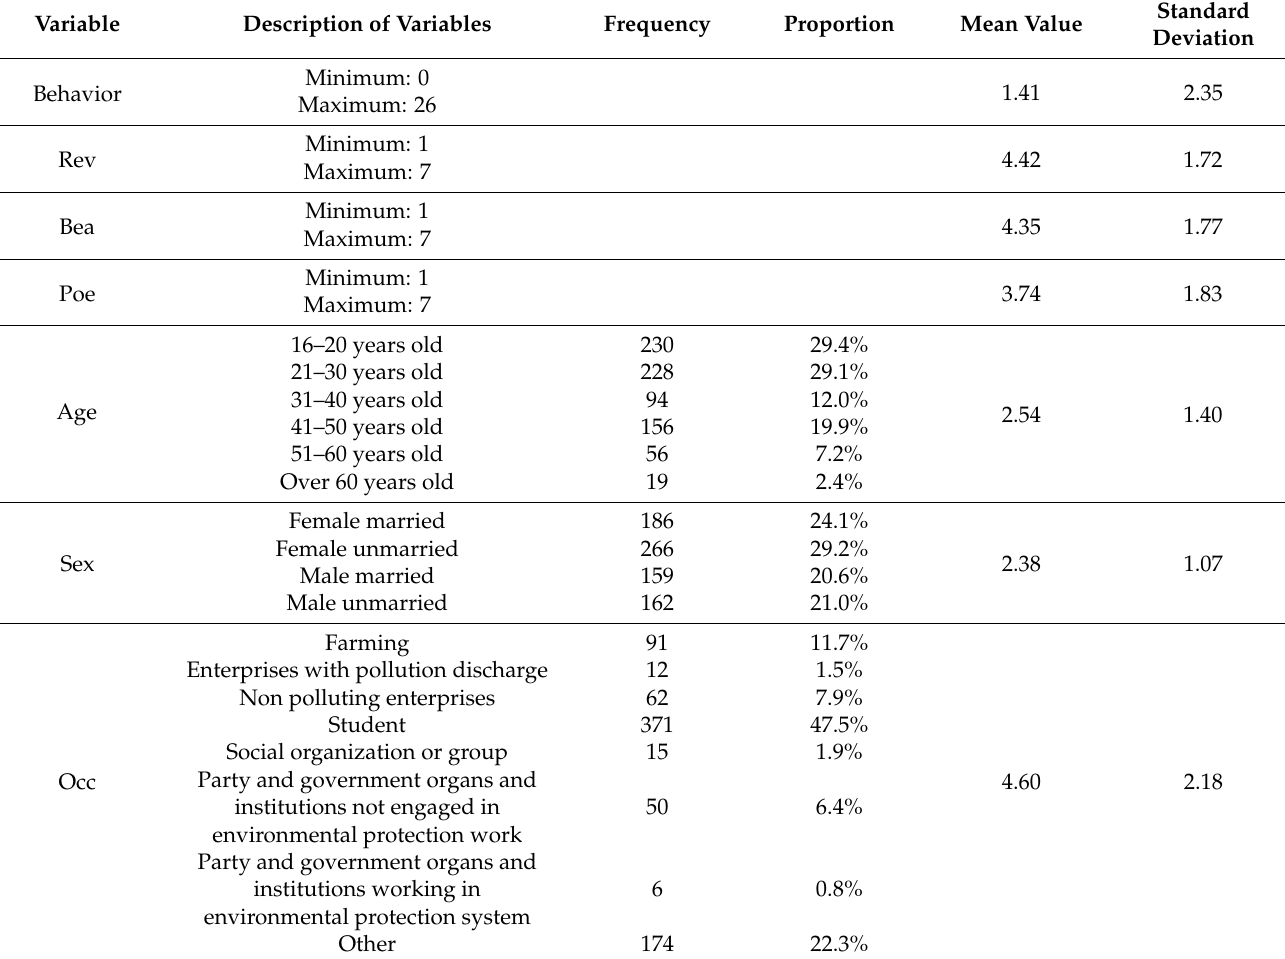
Table A3. Descriptive statistics including variable description, frequency, proportion, mean, standard